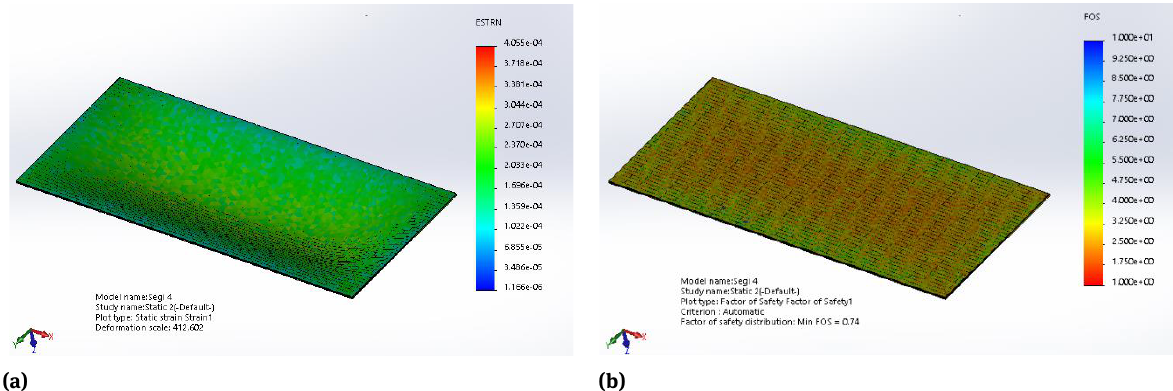
Figure 18: Results for the square honeycomb: (a) Strain and (b) safety factor